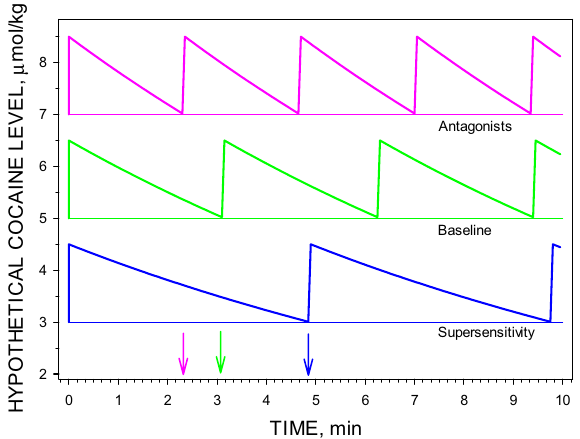
Figure 6. A pharmacokinetic/pharmacodynamic (PK/PD) interaction model. To summarize these results, a model was generated of the effects of irreversible antagonism and supersensitivity on self-administration behavior of the same cocaine unit dose, and assuming that the first-order elimination rate constant of cocaine was unaltered by the treatments. Compared to baseline (green line), supersensitivity of receptors (blue line) results in a decreased satiety threshold. At the lower concentrations, the rate of elimination of cocaine is lower, as dictated by first-order kinetics, and it takes longer for the concentration to decline back to the satiety threshold, resulting in a longer inter-injection interval. Receptor antagonism by both reversible and irreversible antagonists (magenta line) results in an increased satiety threshold. At the higher concentrations, the rate of elimination of cocaine is faster and it takes a shorter time for the concentration to decline back to the elevated satiety threshold resulting on a shorter inter-injection interval. The horizontal lines represent the satiety threshold under each condition. The arrows represent the inter-injection interval duration for each